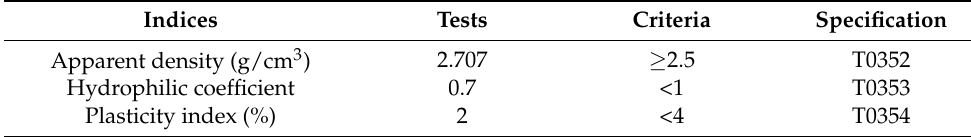
Table 1. Technical properties of the mineral power.